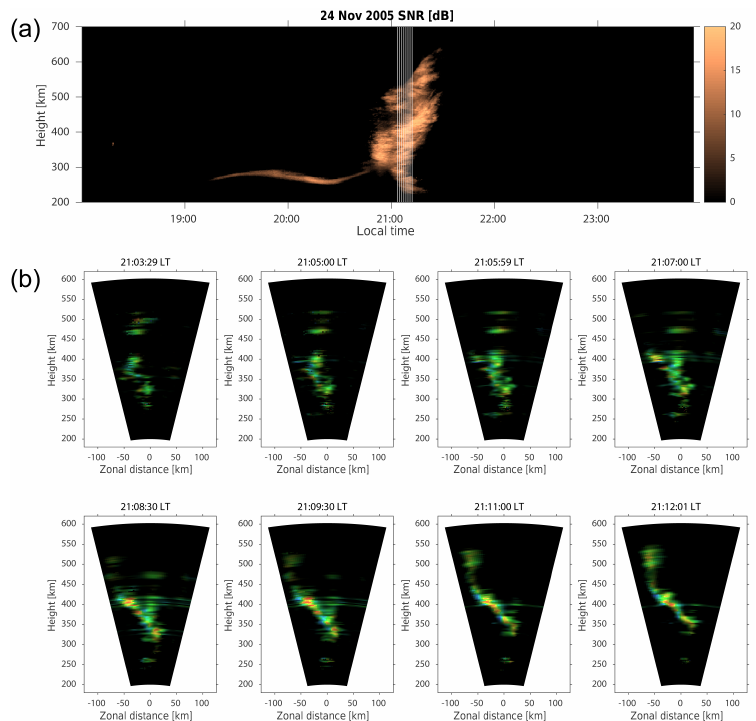
Figure 7. Panel (a) shows the RTI map of F region observations made by the São Luís radar on 24 November 2005. Panel (b) shows a sequence of images obtained with the Capon method and interferometric observations. The time for each image is indicated above each panel and as vertical white lines in the RTI